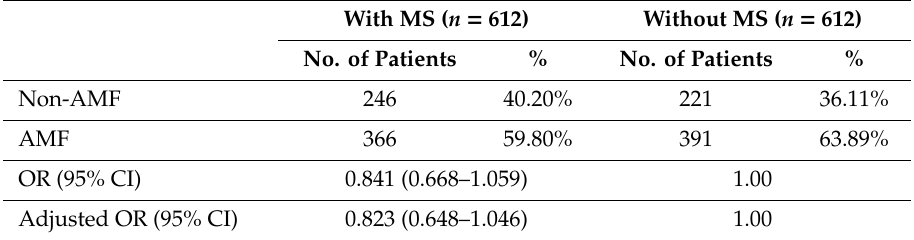
Table 2. Odds ratio for amalgam fillings of those with a diagnosis of multiple sclerosis. With MS ( n = 612)